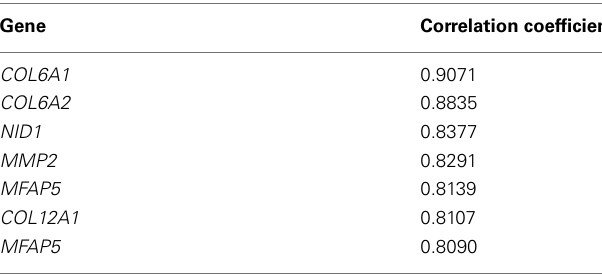
Table 6 | Genes showing expressional correlation with